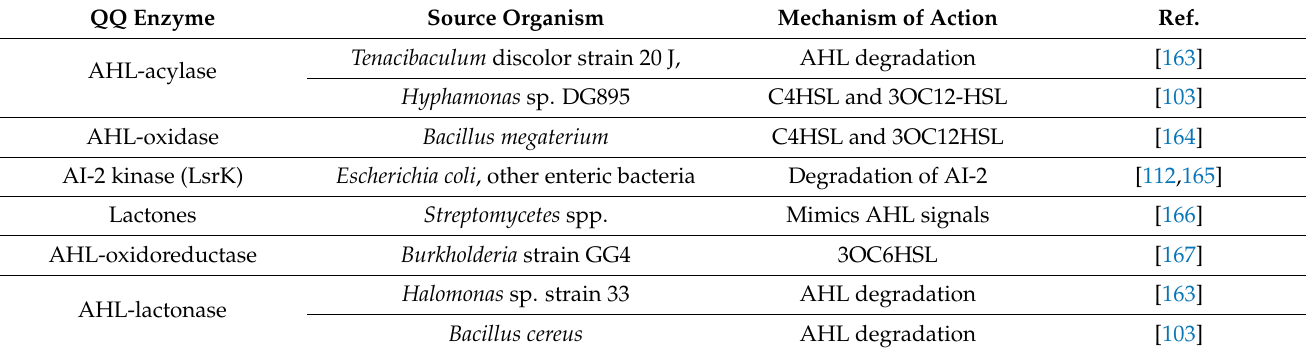
Table 4. Major naturally existing quorum quenching enzymes used in wastewater